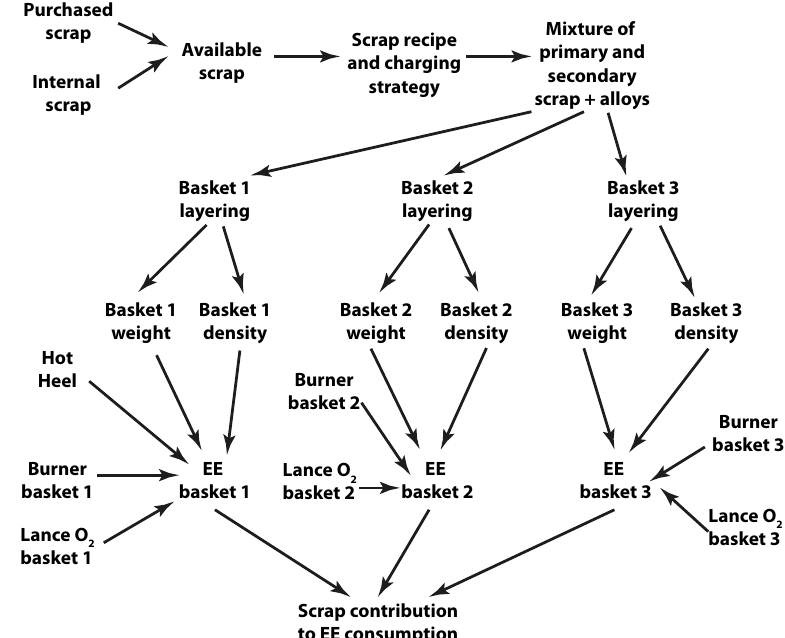
Figure 2. The relationship between the available scrap and the scrap contribution to the Electrical Energy (EE)